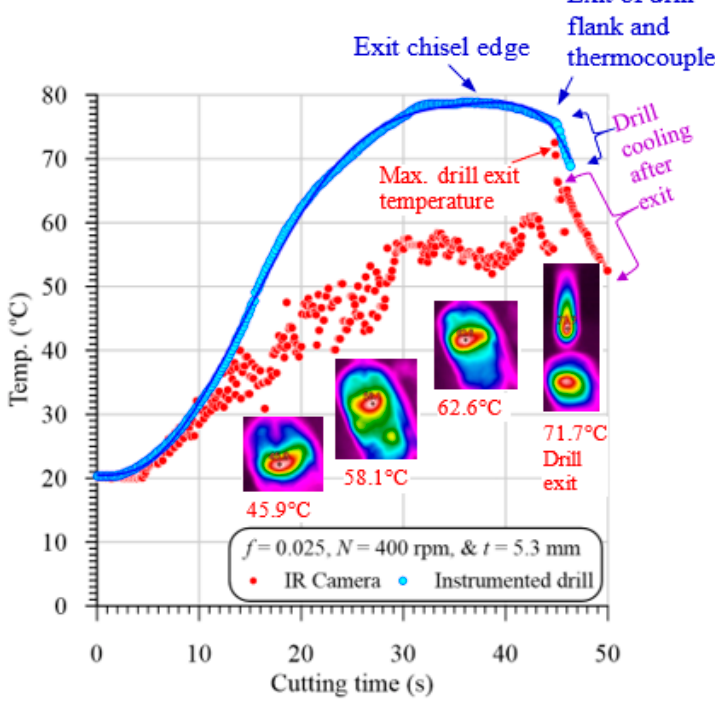
Figure 6. Representative sample of evolution of temperature at hole edge (P0) vs. cutting time in drilling GFRP with 5.3 mm thickness at 400 rpm and 0.025 mm/r using 118 ◦ drill point